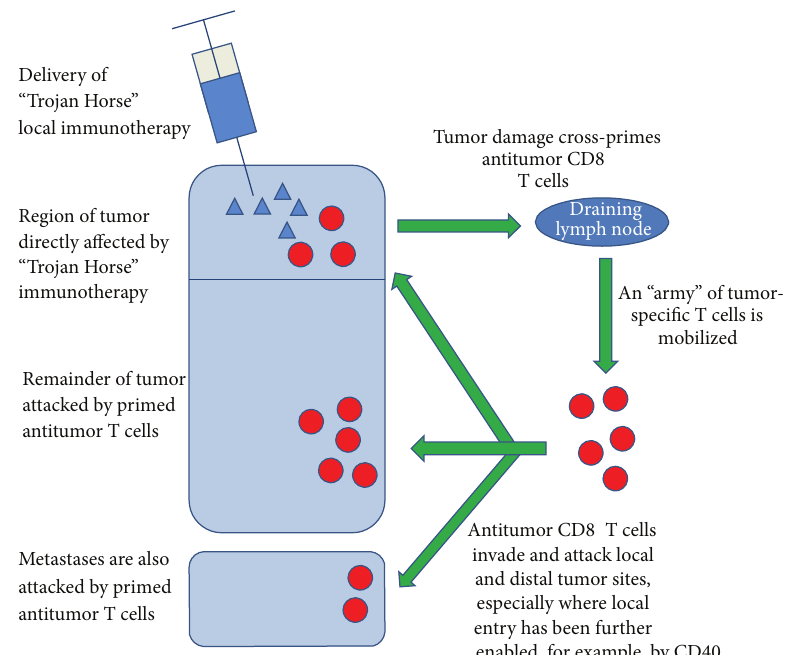
Figure 1: Conceptual illustration of the “Trojan horse” approach to tumor immunotherapy. An immune modulator is delivered directly into a portion of the tumor. That results in inflammation plus “dangerous death”. This results in mobilization of an “army” of tumor specific T cells which then attack the area of the tumor injected plus uninjected areas of tumor, especially if addition agents are provided which promote access of these T cells into these areas and/or local stimulation, for example, agonistic anti-CD40